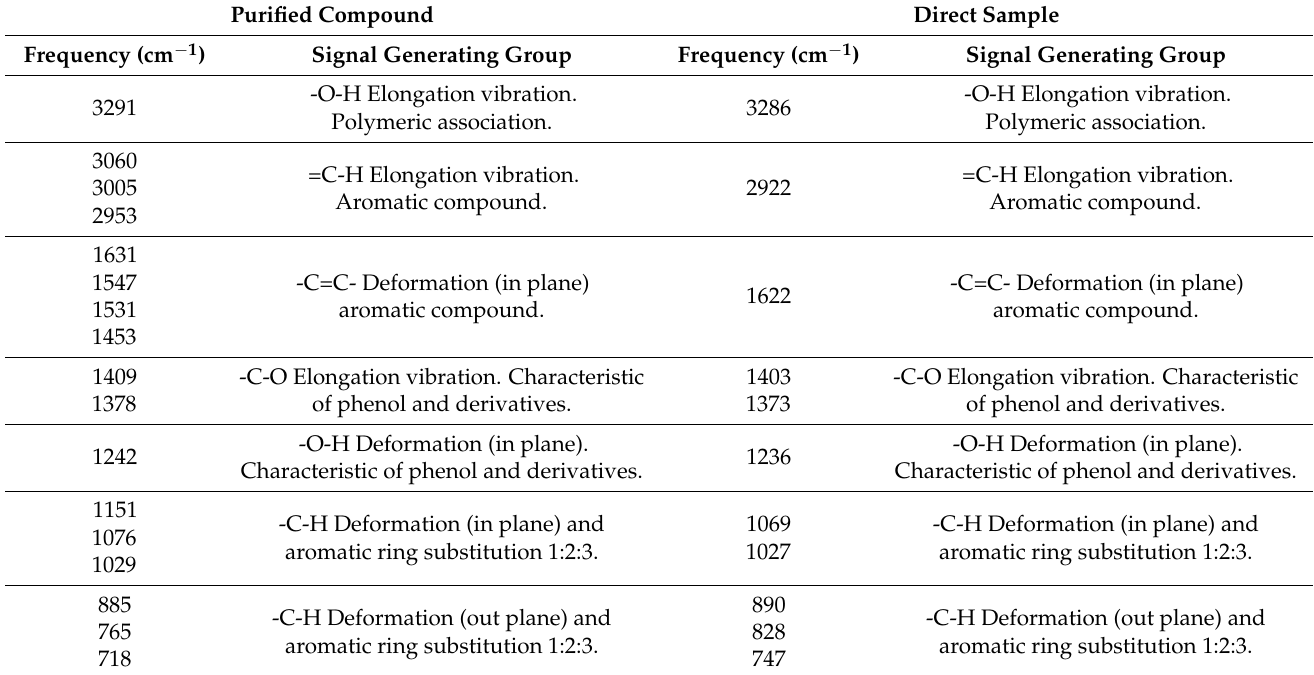
Figure 1. Overlapping FTIR spectra. ( A ) Direct sample and ( B ) purified melanin compound obtained from S. cepivorum sclerotia. The images were obtained by using a stereoscope. ( C ) Spectra obtained by FTIR in diamond ATR of the direct sample (black) and of the purified melanin compound (brown); the principal signals are annotated. Spectra were performed with a diamond ATR attachment Perkin Elmer SPECTRUM 100 infrared spectrophotometer (resolution of 4 cm −1 in the number region of 650 cm −1 to 4000 cm −1 ). Table 1. Melanin S. cepivorum IR signals. Spectra signals of the purified compound and the direct preparation, both from S. cepivorum sclerotia. Identification based on Pretsch tables of spectral data for structure determination of organic compounds [28].